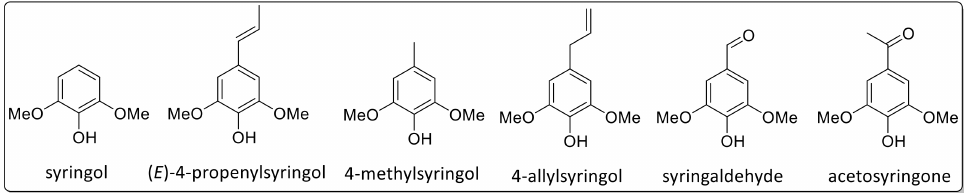
Figure 12. Detected Py-GC/MS fragments attributed to the S-unit.